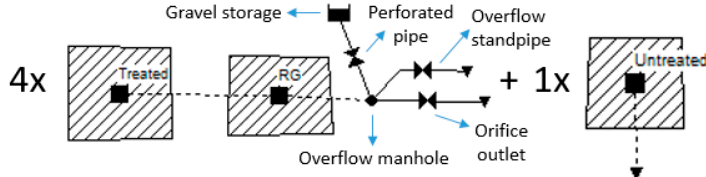
Figure A3. Arbitrary SWMM model setup to study the optimum rain garden area and treated catchment area to achieve C = 0.55.